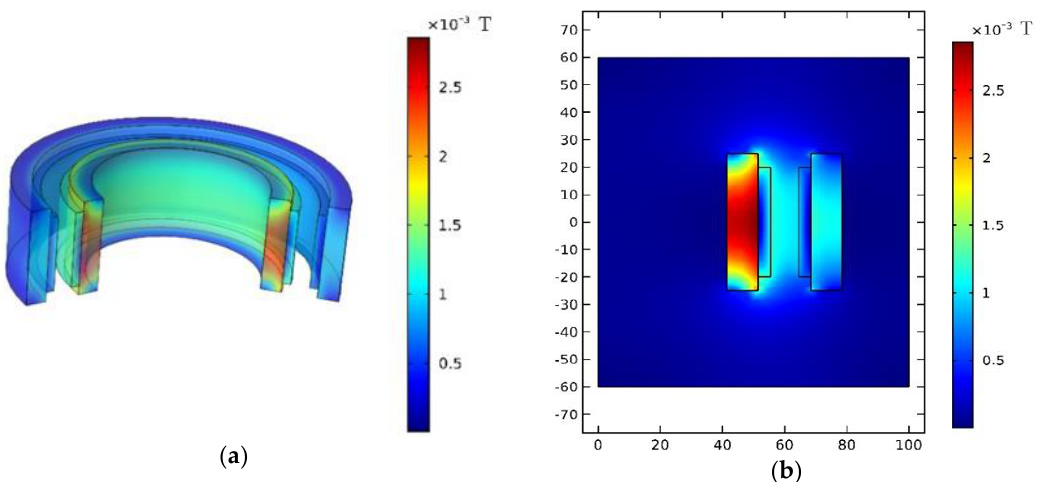
Figure 5. The distribution of magnetic flux density. ( a ) Three-dimensional model; ( b ) two-dimensional axisymmetric model.